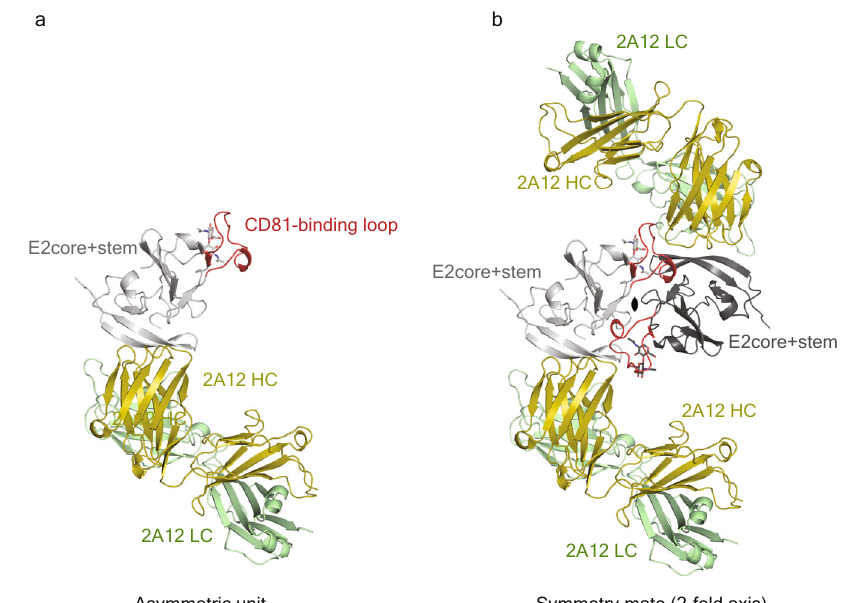
Fig.2|CrystalpackingoftheE2core+stem/2A12Fabcomplex.a Theasymmetric unit of the E2core+stem/2A12 Fab complex is shown. b The crystal packing of the E2core+stem/2A12Fabcomplex,highlightsasymmetrymatearoundatwofoldaxis